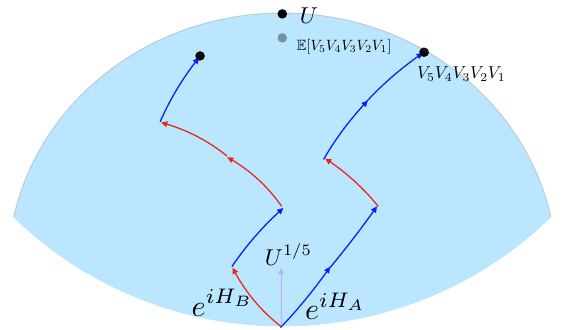
FIG. 2. Illustration of concentration effects for random walks (and their averages) on the unitary group. The expectation E [ V · · · V 1 ] of a random product formula is not unitary, but N it may be very close to the ideal evolution. A sampled ran- dom product formula V N · · · V 1 is unitary, but its distance from (cid:5) the ideal evolution is about O ( nt 2 λ 2 / N ) . The average of the (cid:7) (cid:8) random product formulas results in an error of O t 2 λ 2 / N